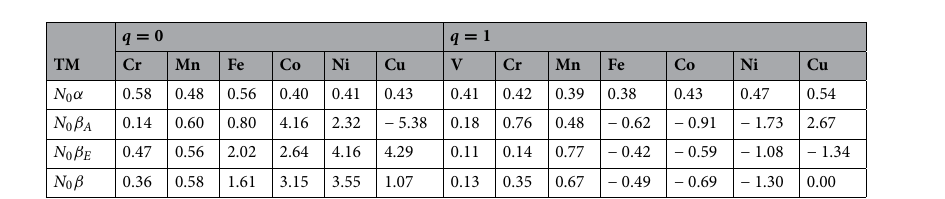
Table 1. Calculated exchange constants N 0 α , N 0 β A and N 0 β E and their average N 0 β (in eV) of TM 2+ and TM 3+ in ZnO.